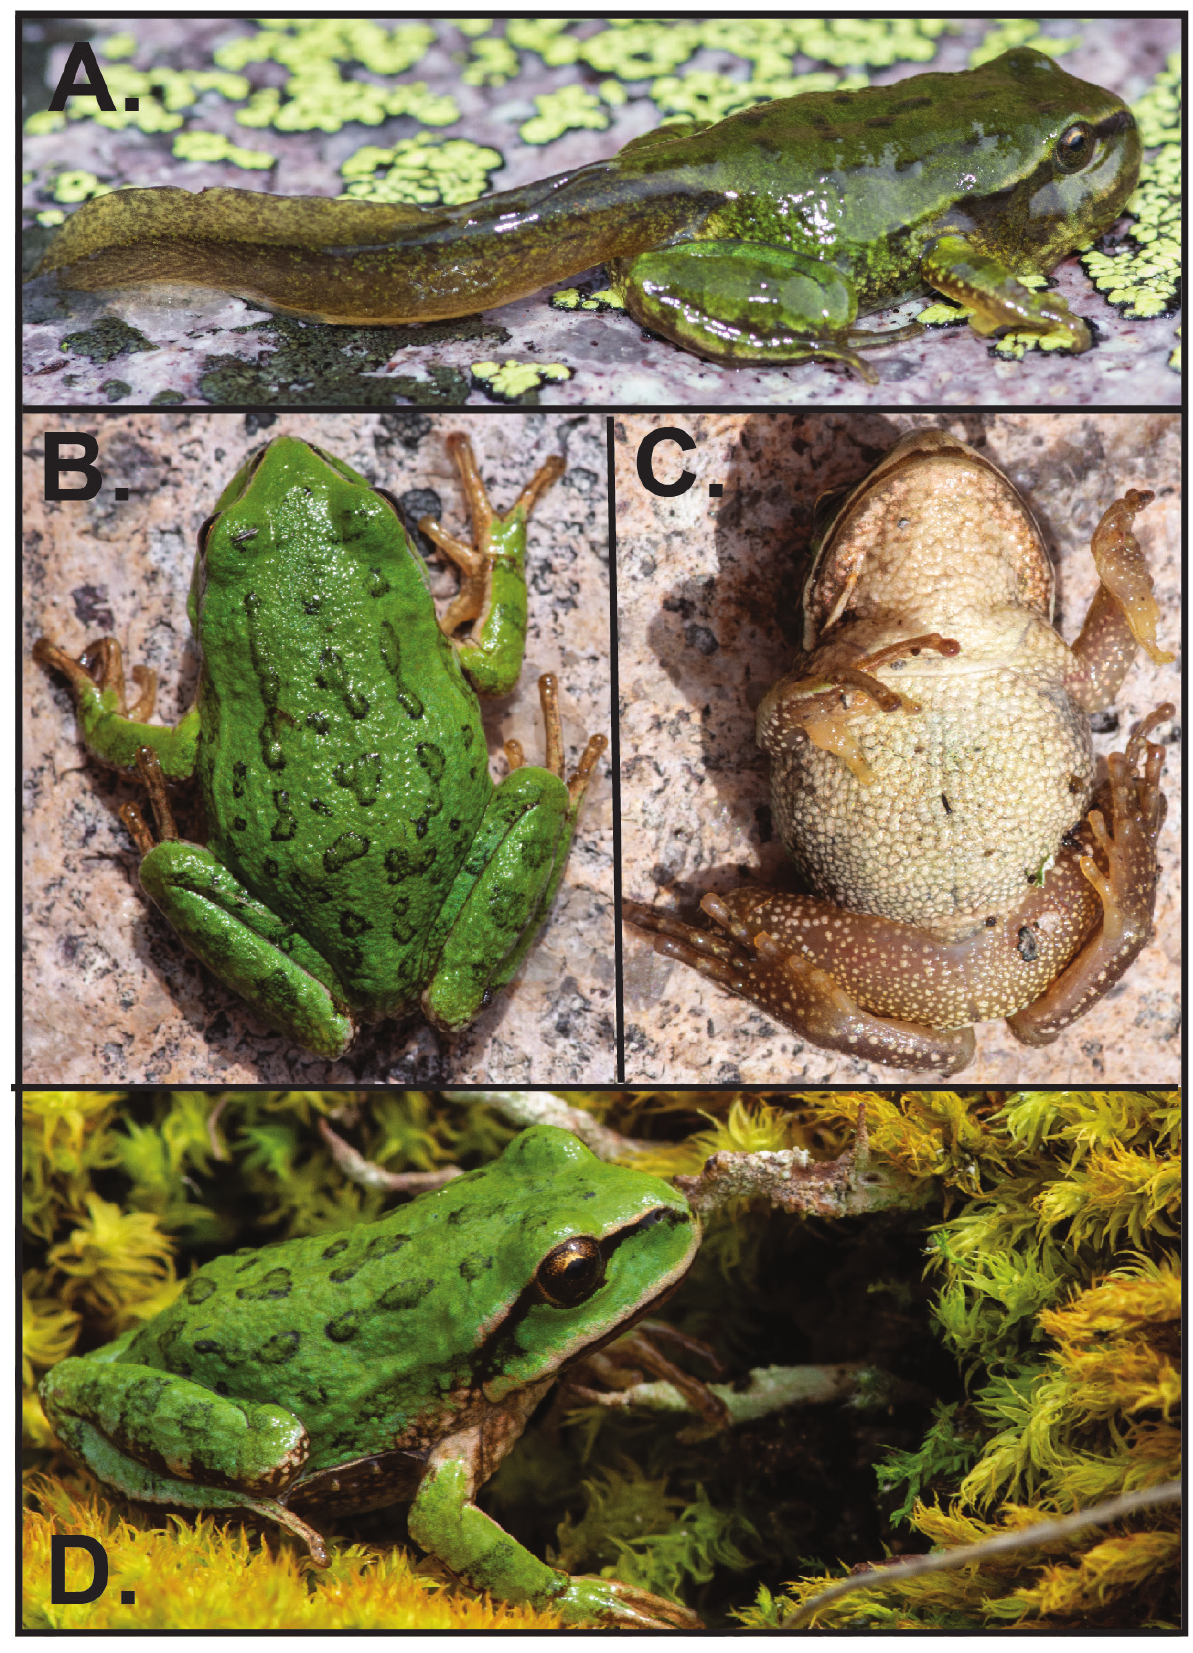
Figure 2. Tadpole and voucher individual of Gastrotheca marsupiata . A. Tadpole. B–D. Voucher individual: ( B ) dorsal, ( C ) ventral, and ( D ) lateral